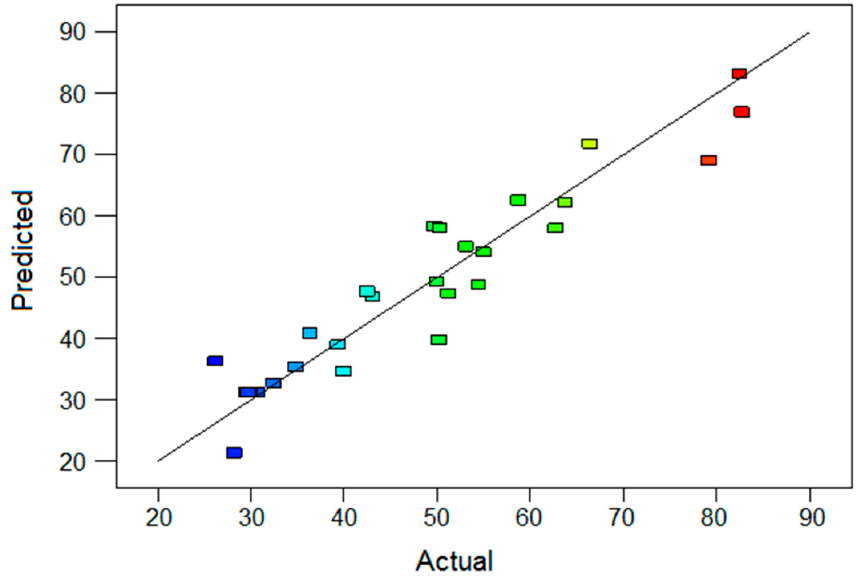
Figure 10. Parity plot of CCD (actual and predicted values for the designed response) pointing to a powerful linear relationship.